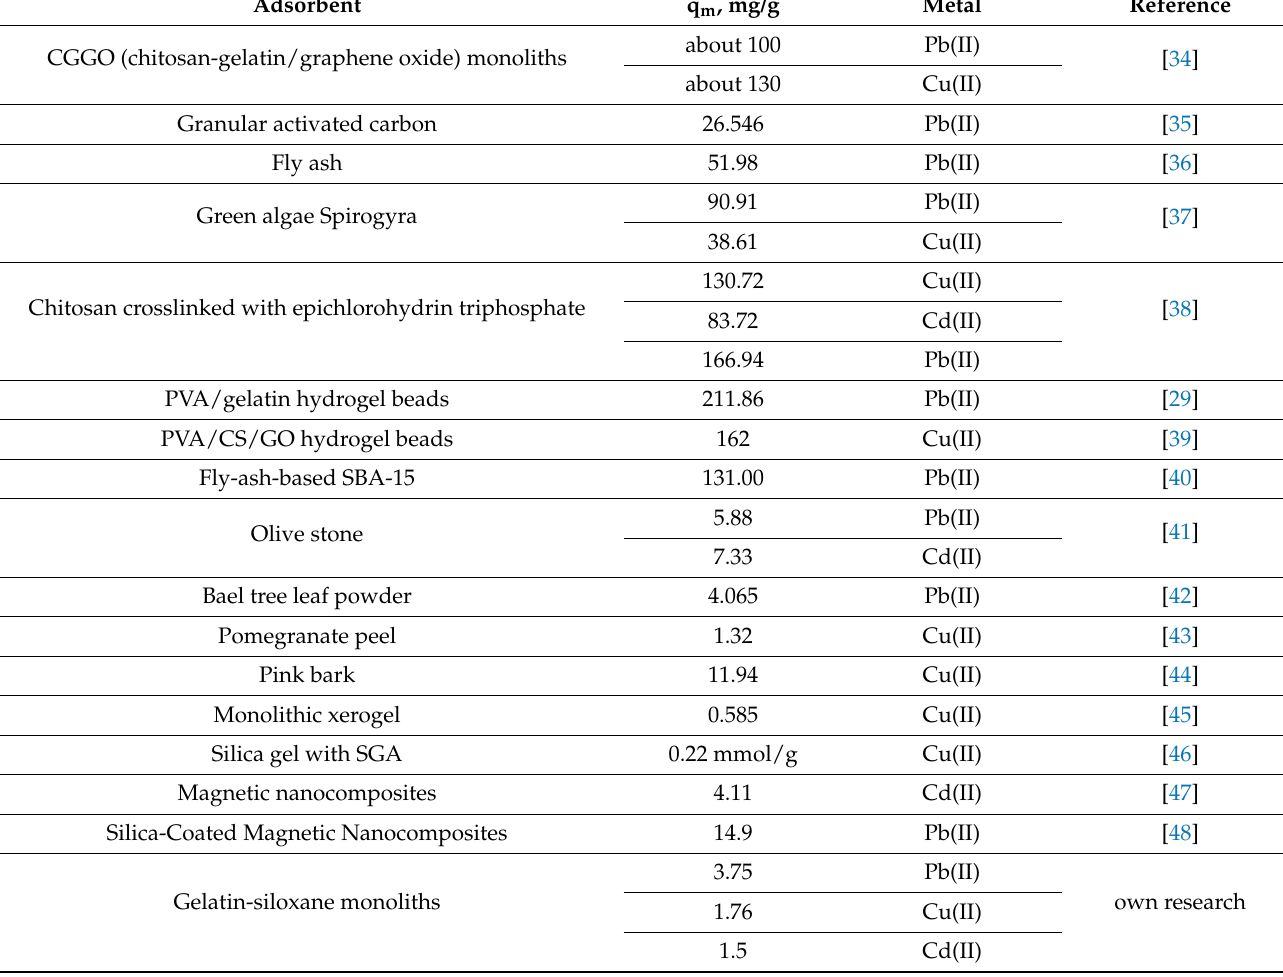
Table 5. The comparison of adsorption capacity of studied metal ions onto various adsorbents. Adsorbent q m , mg/g Metal